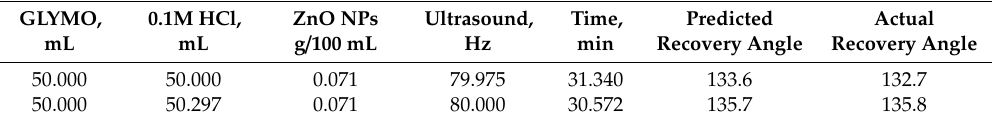
Table 2. Comparison of predicted and actual values of recovery